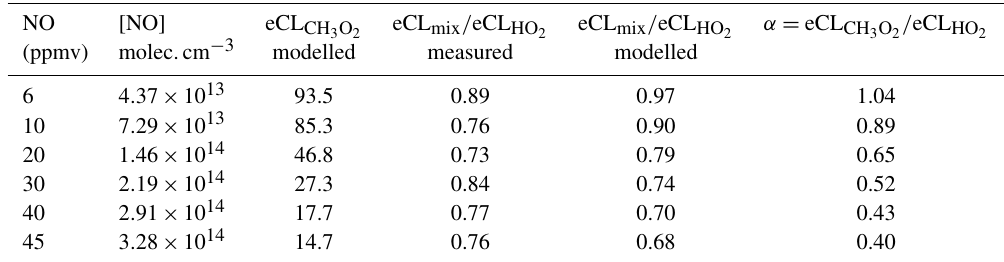
Table 2. PeRCEAS eCL simulated at 300mbar for HO 2 , CH 3 O 2 and a 1 : 1 radical mixture (eCL mix